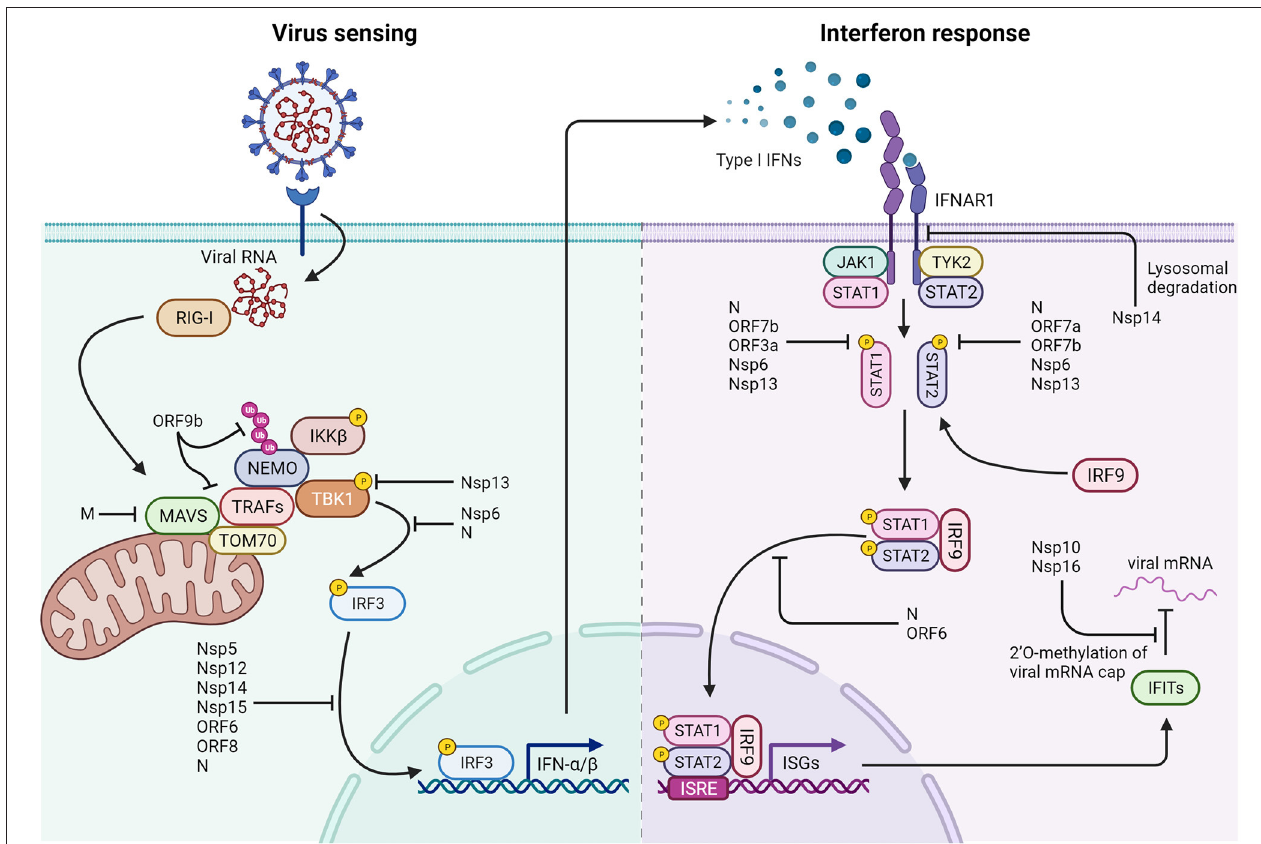
FIGURE 9 | Interactions of SARS-CoV-2 with cellular components of the immune system. Left : SARS-CoV-2 triggers several mechanisms that hinder type 1 interferon production by preventing both viral RNA detection and activity of the IRF3 transcription factor. ORF9b interacts with TOM70 on the mitochondrial surface and prevents K63-polyubiquitination of NEMO. The M protein prevents MAVS aggregation and interaction with downstream proteins. Nsp13 blocks TBK1 phosphorylation by inhibiting its interaction with MAVS, while Nsp6 binds TBK1, and N protein prevents IRF3 phosphorylation. Nsp5, Nsp12, Nsp14, Nsp15, ORF6, ORF8, and N are reported to impair nuclear localization of phosphorylated IRF3. Right : Mechanisms that impair the response to type I interferons: Nsp14 induces lysosomal degradation of type 1 IFN receptor. Nsp6, Nsp13, ORF3a, ORF7a, ORF7b, and N prevent STAT1 and STAT2 phosphorylation. ORF6 and N protein hamper phosphorylated STATs nuclear translocation. In addition, Nsp10 and Nsp16 are responsible for 2’O-methylation of viral mRNA cap, limiting IFITs activation and